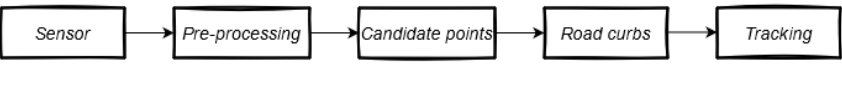
Figure 4. Blocks Diagram for the road curb detection.